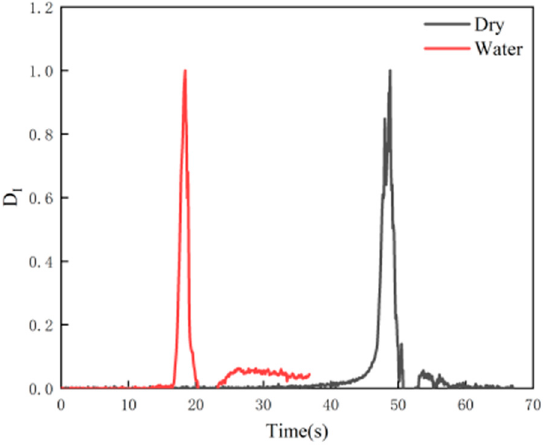
Figure 12. D I of CR mixture before and after immersion under low-temperature fracture.